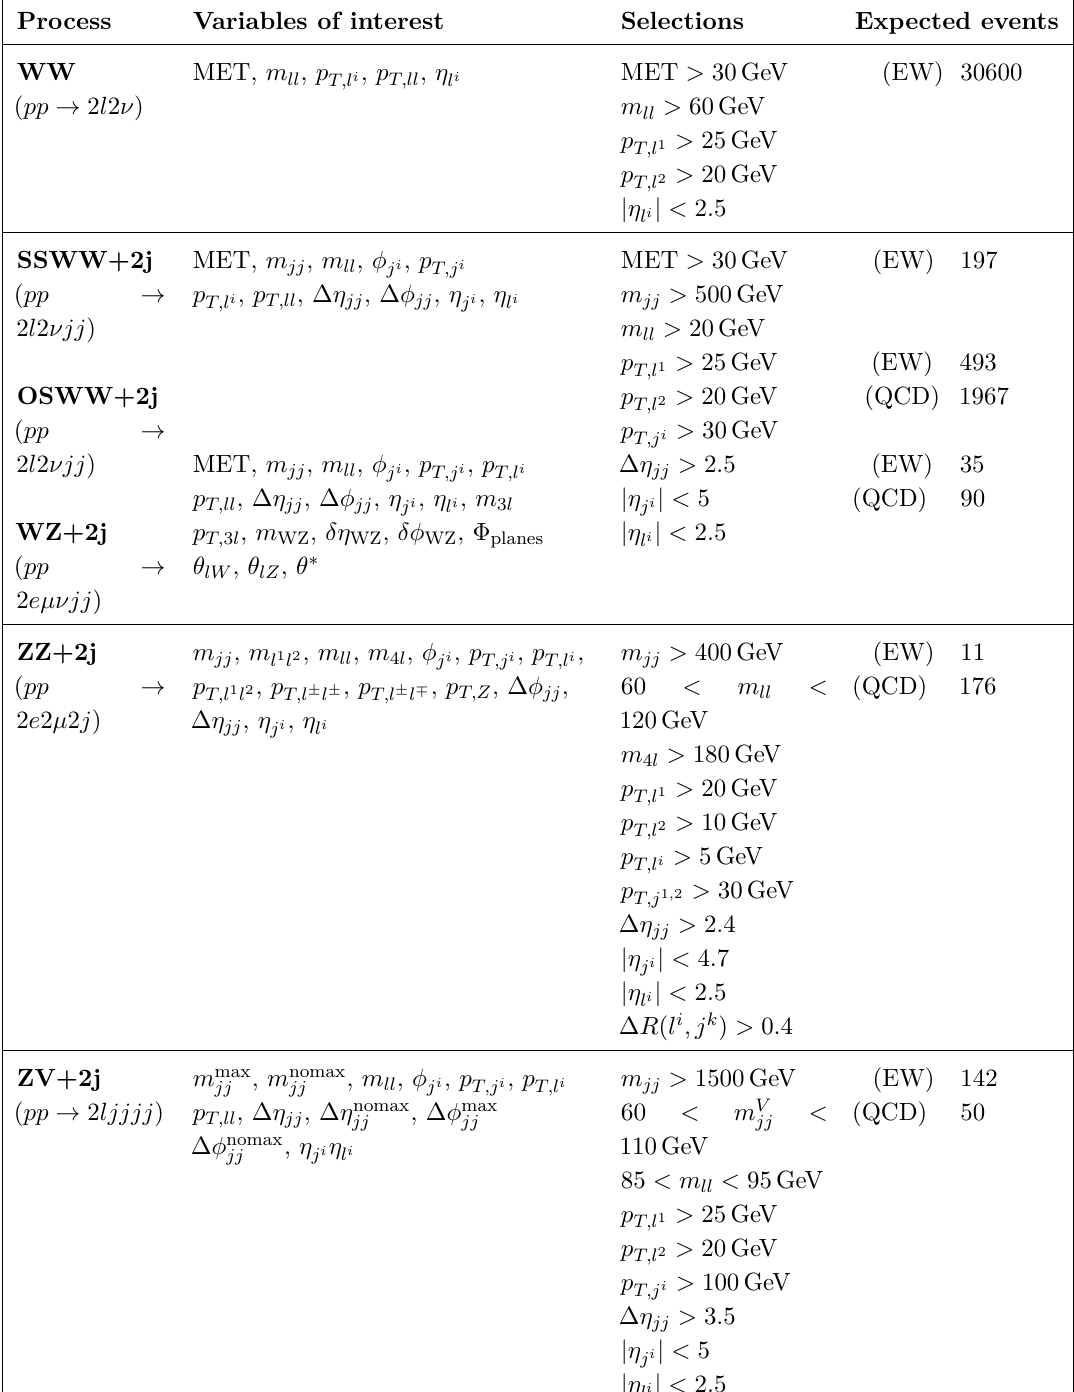
Table 4 . Summary table for processes, variables and selections considered in this work. The second column lists the observables examined, while the third one summarises the parton level phase space definition used in this analysis. The last column reports the expected SM event yields of the EW and QCD-induced processes after the analysis selections, for an integrated luminosity of 100 fb − 1 . The charged lepton shortcut l stands for electron or